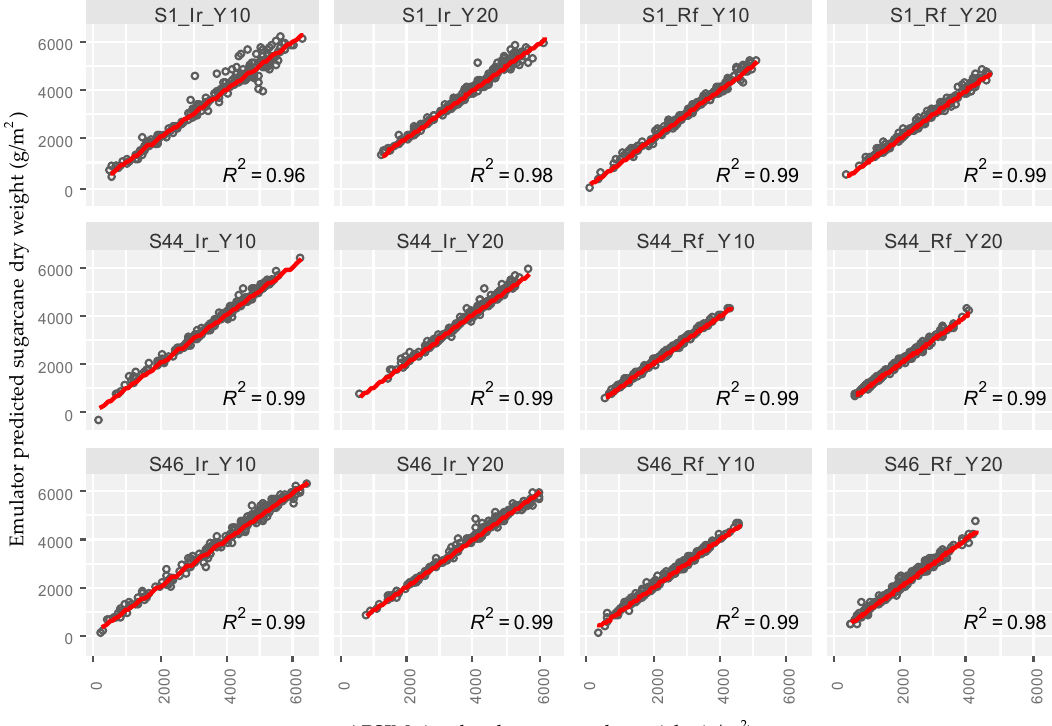
Figure 2. Relationship between APSIM simulated cane dry weight (CDW) and emulator predicted CDW of year (Y) 10 and year (Y) 20 between (1980–2010) under three soil types (S1, S44 and S46) and irrigated (Ir) and rainfed (Rf) conditions. Solid red lines indicate linear fit to the APSIM simulated CDW and emulator predicted CDW values.